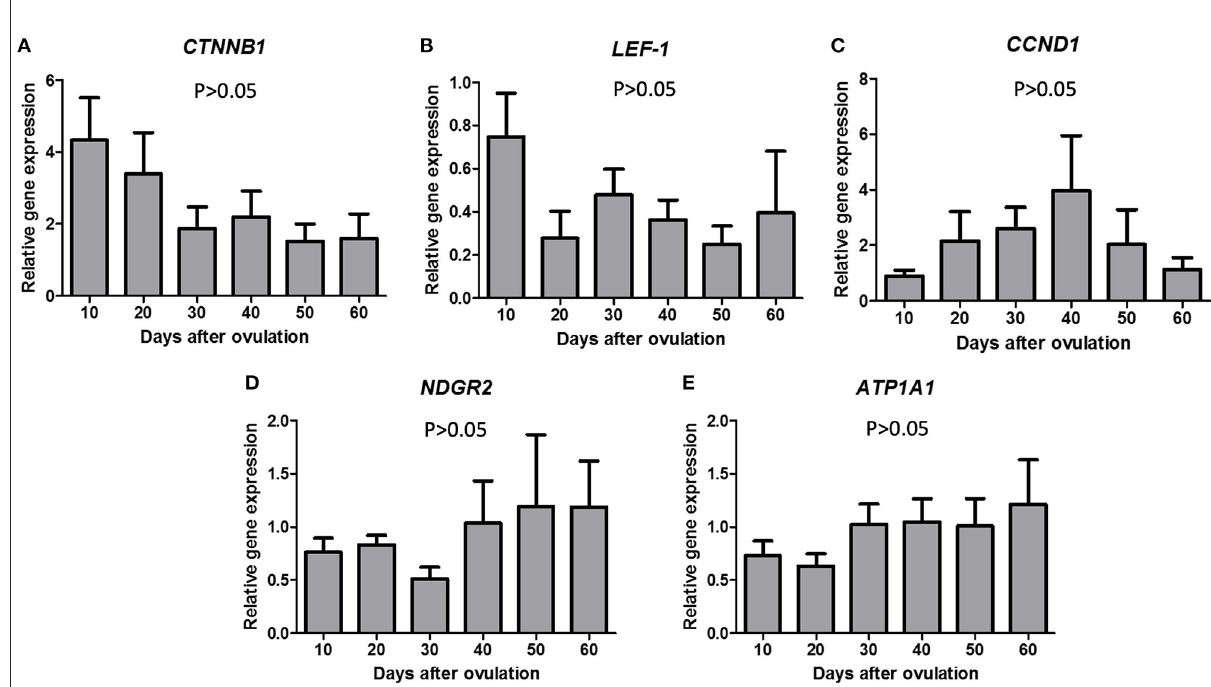
FIGURE2 Gene expression of CTNNB1 (A) , LEF-1 (B) , CCND1 (C) , NDGR2 (D) , and ATP1A1 (E) in canine CL during diestrus (10 to 60 days p.o.). Data are presented as mean ± standard error of relative gene expression ( n = 4 or 5 animals/group). No difference among groups were observed ( P > 0.05).